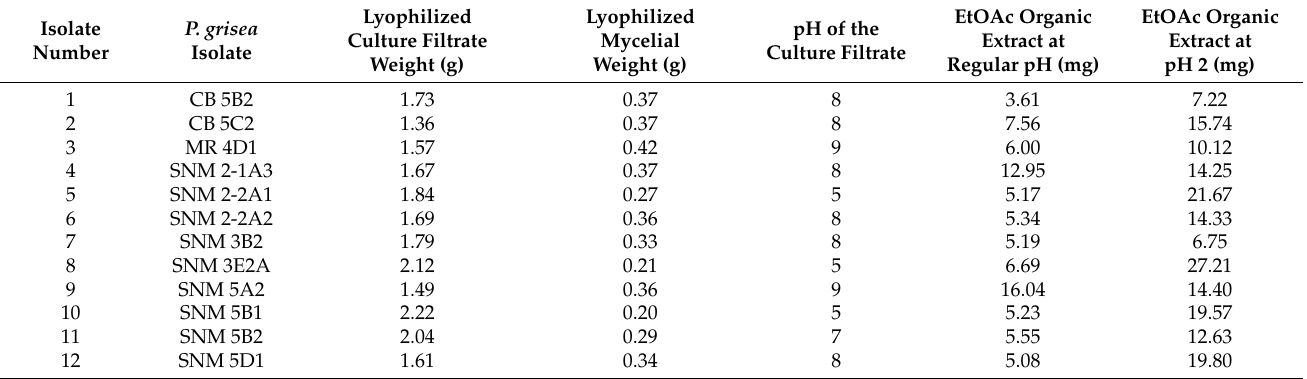
Table 1. Data about the twelve isolates of Pyricularia grisea , their culture filtrates, and organic extracts 1 .